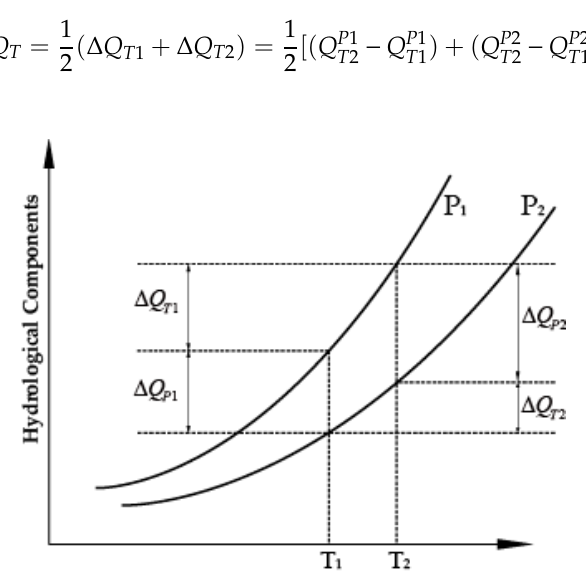
ff ects of temperature and